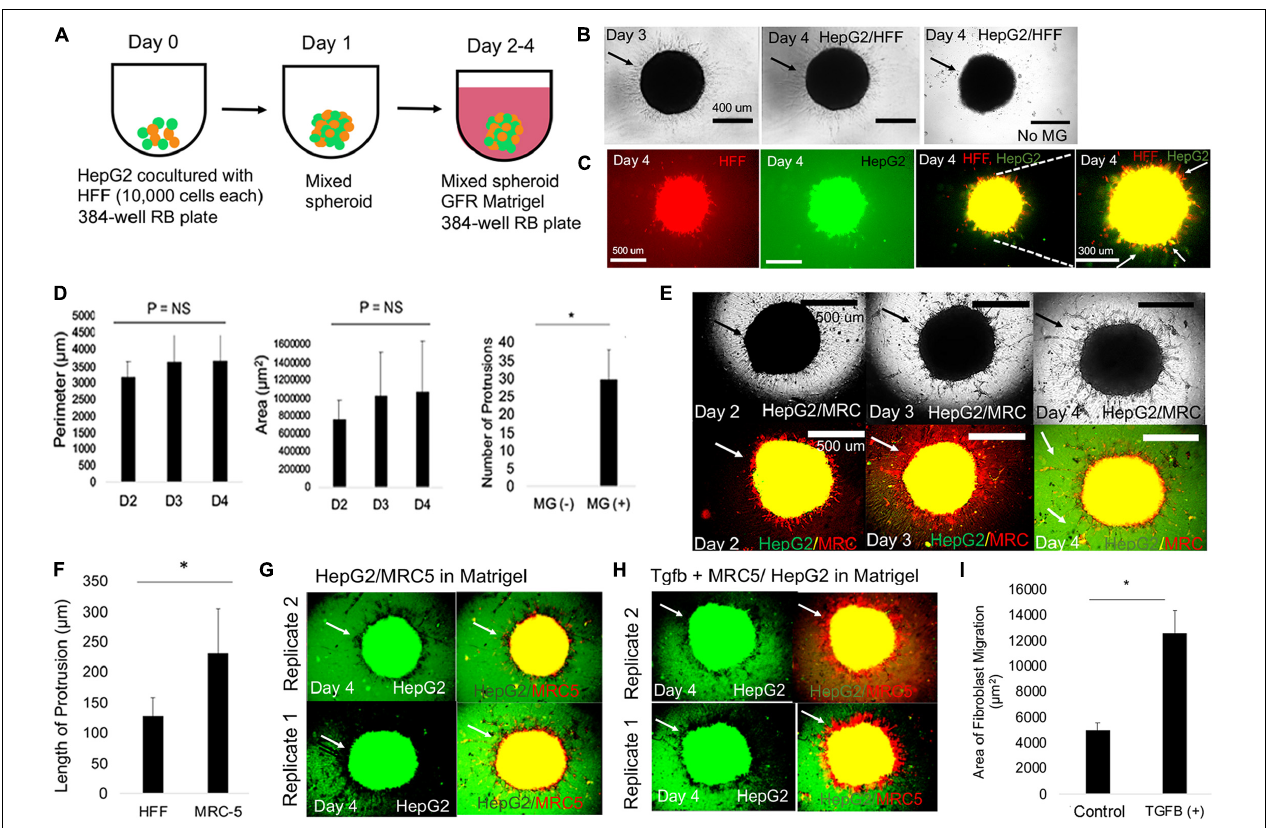
FIGURE 2 | Mixed spheroids with fibroblasts result in 3D liver collective cell migration. (A) Schematic for modeling the LD with mixed spheroid containing HepG2 cells and HFF cells cultivated for 1 day followed by embedding in MG from days 2–4. (B) Phase-contrast images of HepG2-GFP/HFF-mixed spheroids in MG on days 3 and 4, and day 4 no MG (negative control) condition. Arrows in the HepG2/HFF condition migration of HFF cells into the MG. In the control condition containing no MG, arrows denote lack of migration. (C) Fluorescent images of day 4 HepG2-GFP/HFF-mixed spheroids in MG. From left to right: HFF (red) cells, HepG2-GFP (green), HFF/HepG2 (red, green), and HFF/HepG2 (high magnification). White arrows show red, yellow, and green projections. (D) Bar graph plotting perimeter (left), area (middle) of day 2 HepG2-GFP/HFF-mixed spheroids over time. P = NS ( n = 3). Right: bar graph plotting number of protrusions in the HepG2/HFF spheroids on day 4 in without MG (MG -) and with MG (MG+) ( P = 0.022, n = 3). Plotted is mean ± SD. Significance defined as P ≤ 0.05. (E) Phase-contrast (above) and fluorescent images (red, green) below of HepG2-GFP/MRC-5-mixed spheroids in MG on days 2, 3, and 4 and a day 4. Arrow in the picture specifies emergence of finger-like protrusions. (F) Bar graph comparing length of protrusion ( P = 0.0076, n = 3) on day 4 between HFF and MRC-5 experimental condition. Plotted is mean ± SD. Significance defined as P ≤ 0.05. (G) Fluorescent images of day 4 of HepG2-GFP/MRC-5-mixed spheroids in MG. From left to right: HepG2 (green) cells and combined HepG2 (red) and MRC-5 (yellow) images. Replicates 2 (above) and 1 (below) are shown. Arrows show HepG2 and MRC-5 migration. (H) Fluorescent images of day 4 of HepG2-GFP/MRC-5-mixed spheroids in MG after treatment with TGF β 1 (20 ng/ml). From left to right: HepG2 (green) cells and combined HepG2 (red) and MRC-5 (yellow) images. Replicates 2 (above) and 1 (below) are shown. Arrows show HepG2 and MRC-5 migration. (I) Bar graph comparing area of fibroblast migration in negative control (HepG2-GFP/MRC-5) and (HepG2-GFP/MRC-5 + TGF β 1, 20 ng/ml), P = 0.012, n = 3. Plotted is mean ± SD. Significance defined as P ≤ 0.05. ∗ is used to denote significance of experimental